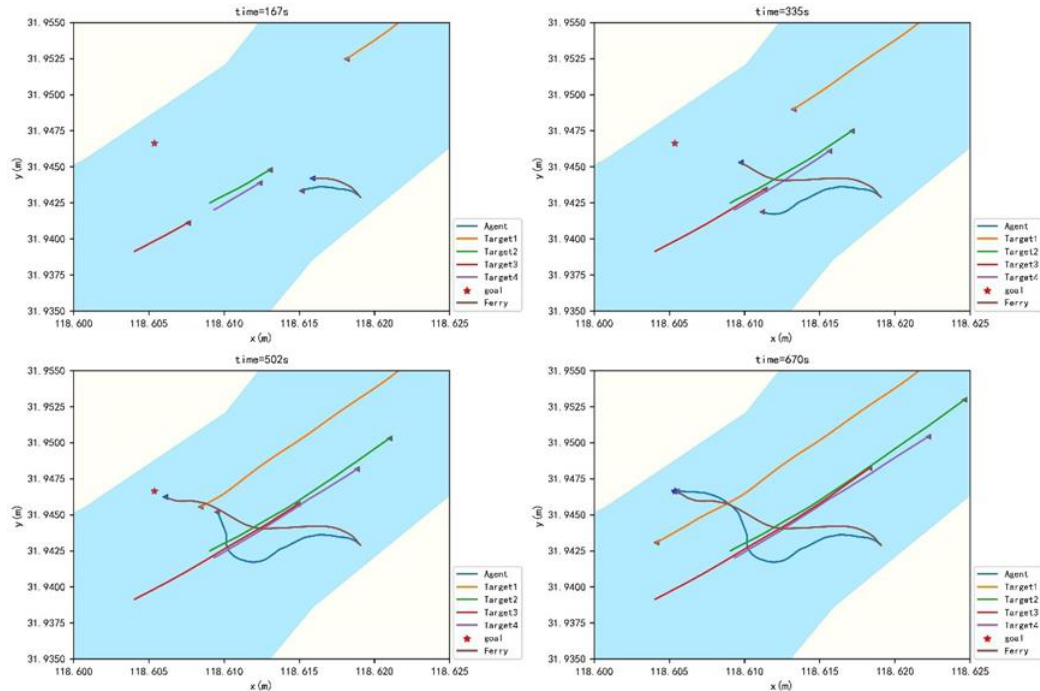
Figure 15. Trained and actual trajectories.